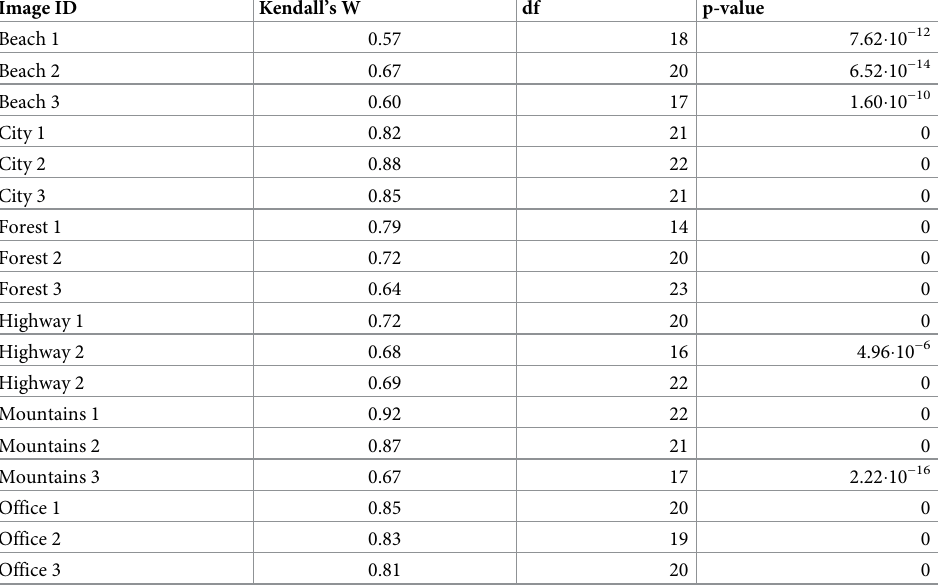
Table 1. Inter-rater agreement of line drawing